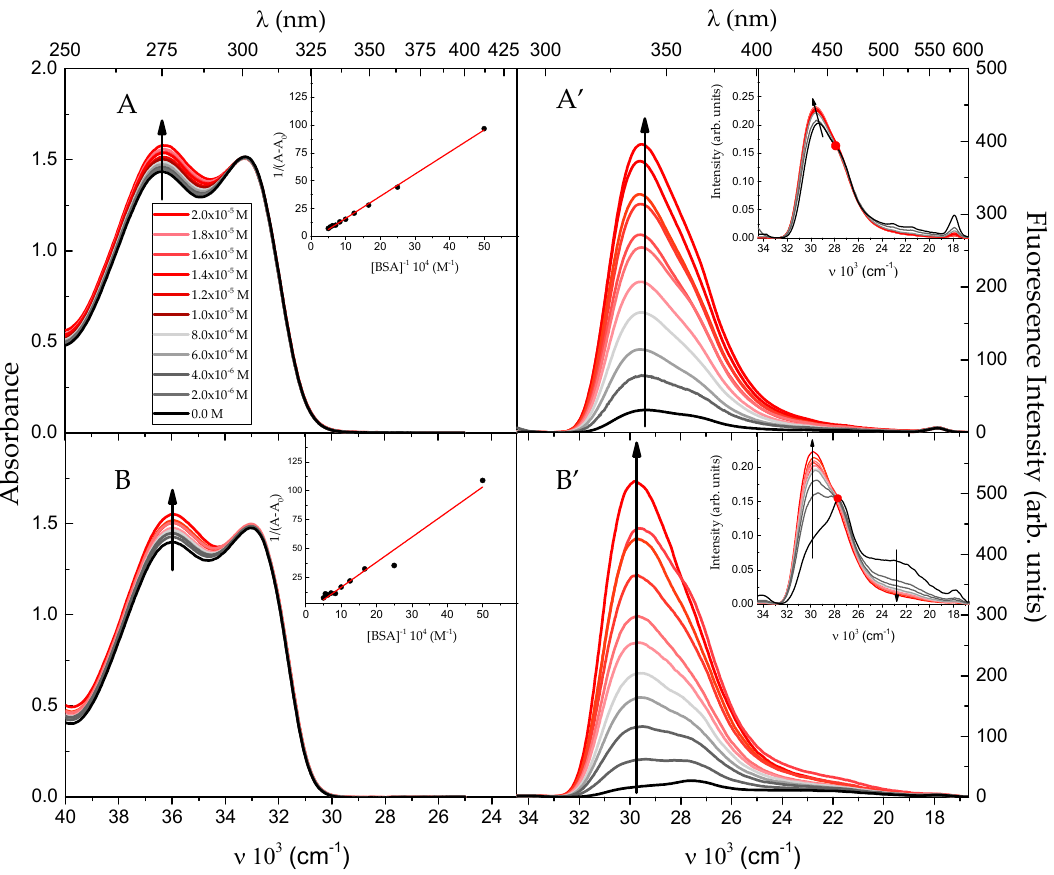
Figure 2. Absorption and fluorescence spectra ( λ exc. = 300 nm) of I ( A , A’ ), II ( B , B’ ) (c = 5 × 10 − 5 M) in phosphate buffer solutions containing different concentration of BSA (0 M, 2.0 × 10 − 6 M, 4.0 × 10 − 6 M, 6.0 × 10 − 6 M, 8.0 × 10 − 6 M, 1.0 × 10 − 5 M, 1.2 × 10 − 5 M, 1.4 × 10 − 5 M, 1.6 × 10 − 5 M, 1.8 × 10 − 5 M, 2.0 × 10 − 5 M). Insert the ground-state Benesi–Hildebrand dependence for I ( A ), II ( B ) and the normalized fluorescence spectra of I ( A’ ) and II ( B’ ) in phosphate buffer solutions containing different concentration of BSA.